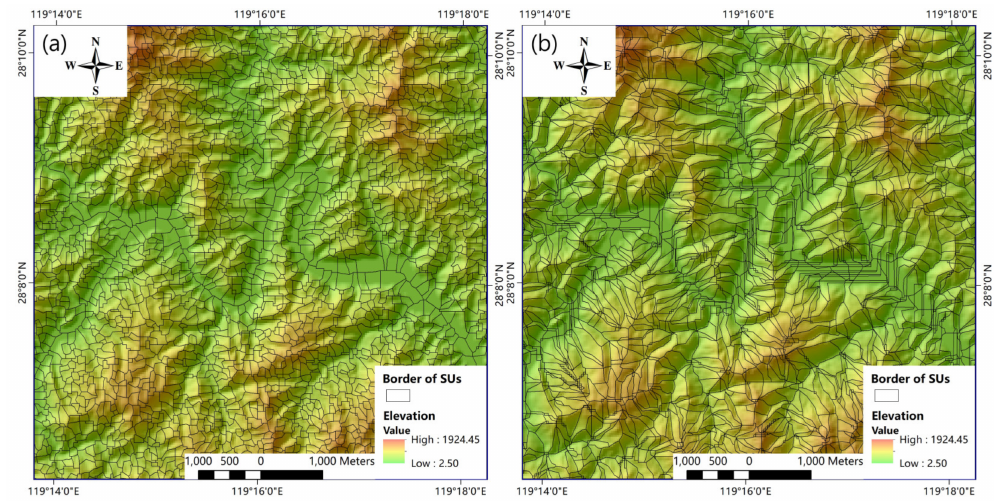
Figure 5. Comparison of the effects of slope units (SUs) using two methods in a certain section of Lishui City: ( a ) improved method and ( b ) hydrology analysis-based method.